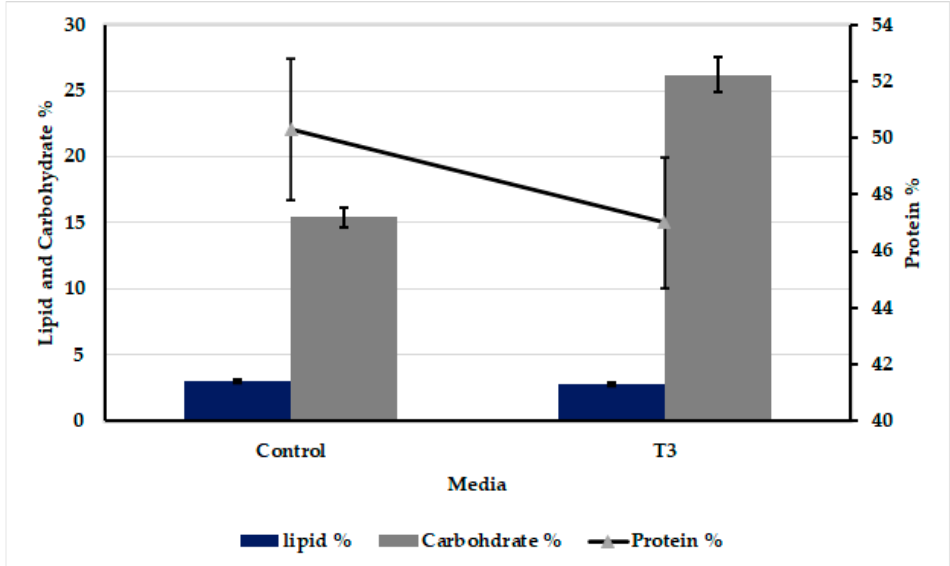
Figure 4. Biochemical composition of O. sancta grown on Zarrouk’s medium (control) and 12.5% modified Zarrouk’s medium concentration (T3). Error bars show the SD for three measurements. Carbohydrate content was relatively high at T3 (26.2 ± 1.31%) compared with the